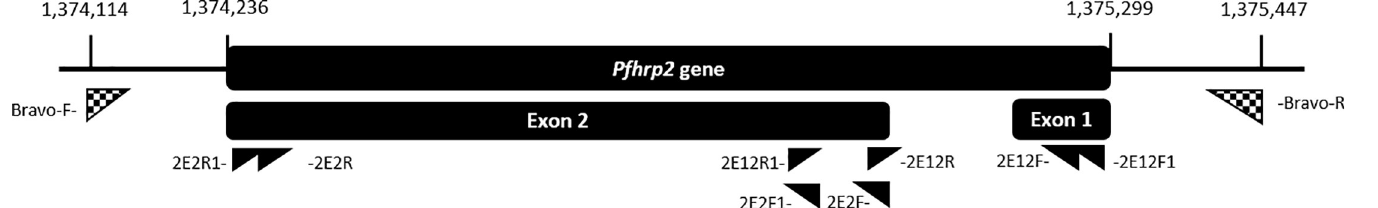
Fig 1. Location of novel one-step primers, and nested pfhrp2 primers. Locations on chromosome 8, are listed above the schematic. Nested PCR primers are explained in Table 1. One-step primers are shown in a checked pattern. Primer pairing is detailed in Table 1. Note: primers 2E12R1 and 2E2F1 occupy the same location.